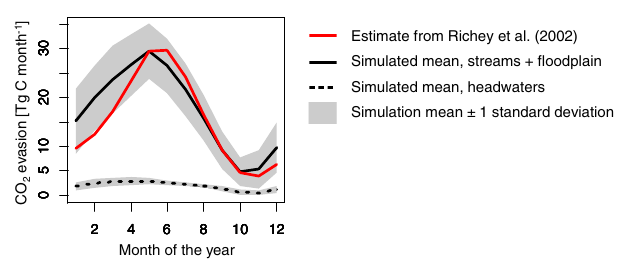
Figure 18. Seasonality in CO 2 evasion from inland waters (rivers plus floodplains, including swamps) within the central Amazon basin (see map in Fig. 4). The simulation result reports the mean monthly CO 2 evasion during the simulation period 1980–2000 as well as the standard deviation of monthly mean simulated val- ues during the same period. The CO 2 evasion from headwaters is here represented by the CO 2 evasion from S fast . Simulation re- sults are compared with the observation-based estimate by Richey et al. (2002), given here as the sum of the evasion from the Ama- zon main channel, the tributaries and the floodplains. R 2 = 0 . 85, RMSE =